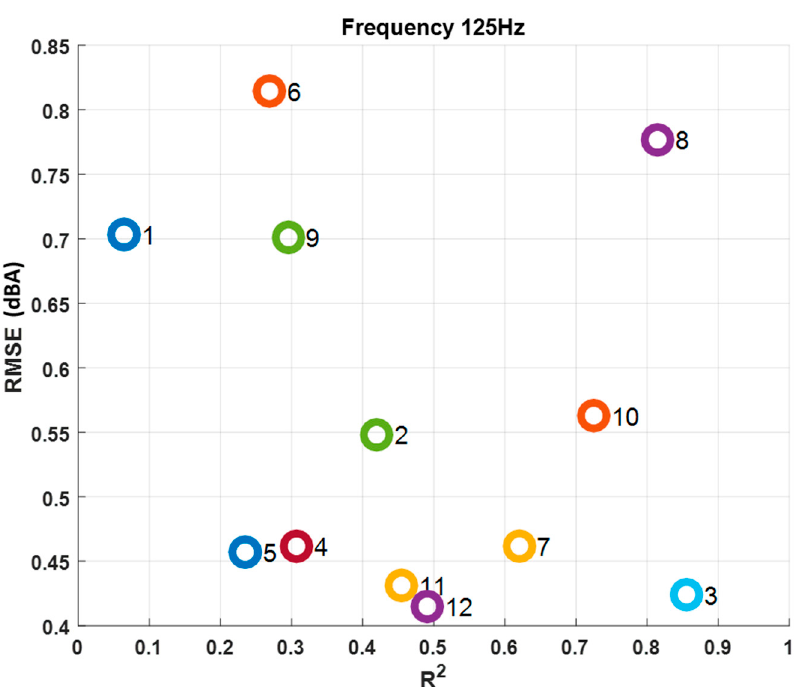
Figure 13. Predicted effect at 125 Hz for different sensors.